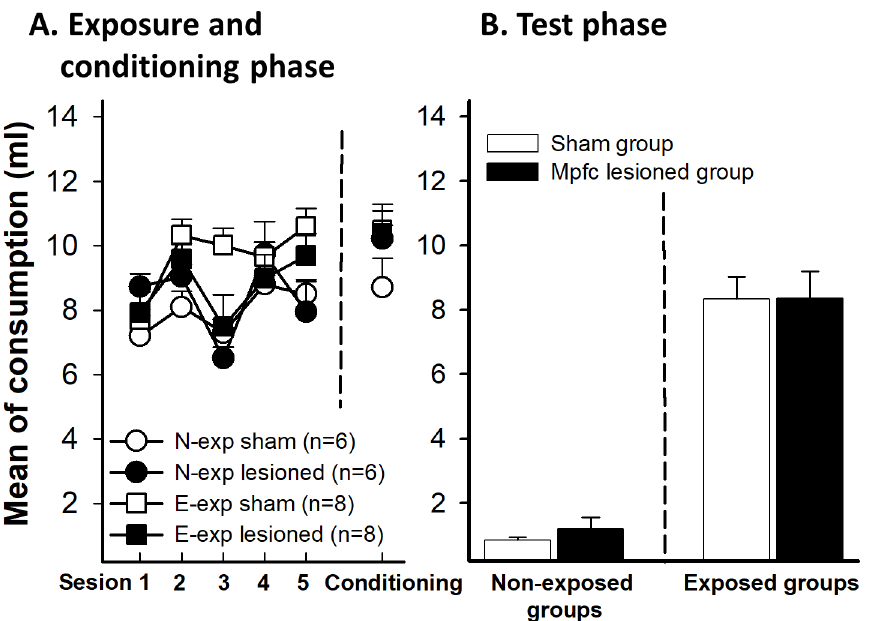
Fig 5. Saccharin intake for sham and mpfc lesioned animals (E-exp and N-exp). As experiment1, A (left) shows the five sessionsof preexposure phaseand (right) saccharinintake duringconditioning phase. B . Effects of mpfc lesionin extendedexposure groups(E-exp) duringthe test phase. Error bars represent SEMs. N-exp: non exposedgroups, E-exp: extendedexposure groups.